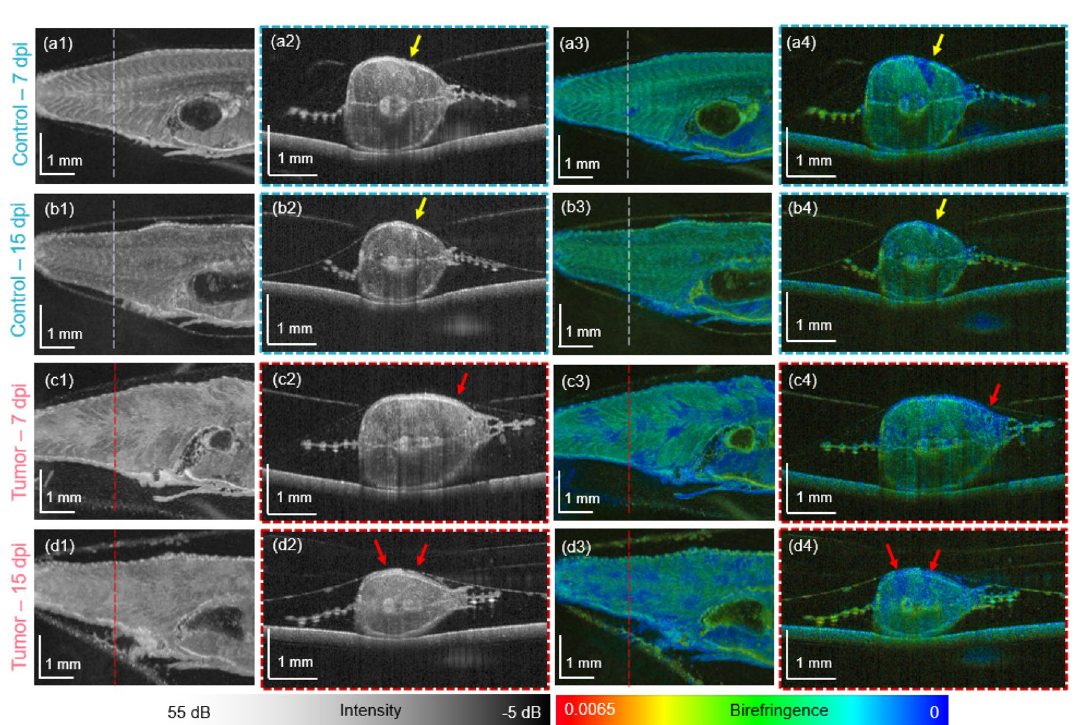
Figure 3. The scatter and polarization JM-OCT results over time in a control ( a1 – b4 ) and a tumor injected zebrafish ( c1 – d4 ). ( a1 – a2 ) Scatter-intensity en-face and B-scan images in a control fish at 7 days post injection (dpi). ( a3 – a4 ) Corresponding birefringence en-face and B-scan images. ( b1 – b 2) Scatter-intensity en-face and B-scan images in a control fish at 15 dpi. ( b3 – b4 ) Corresponding birefringence en-face and B-scan images. ( c1 – c2 ) Scatter-intensity en-face and B-scan images in a tumor fish at 7 dpi. ( c3 – c4 ) Corresponding birefringence en-face and B-scan images. ( d1 – d2 ) Scatter-intensity en-face and B-scan images in a tumor fish at 15 dpi. ( d3 – d4 ) Corresponding birefringence en-face and B-scan